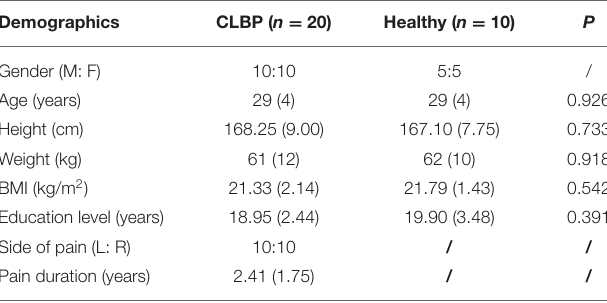
TABLE 2 | Sample characteristics (mean ±